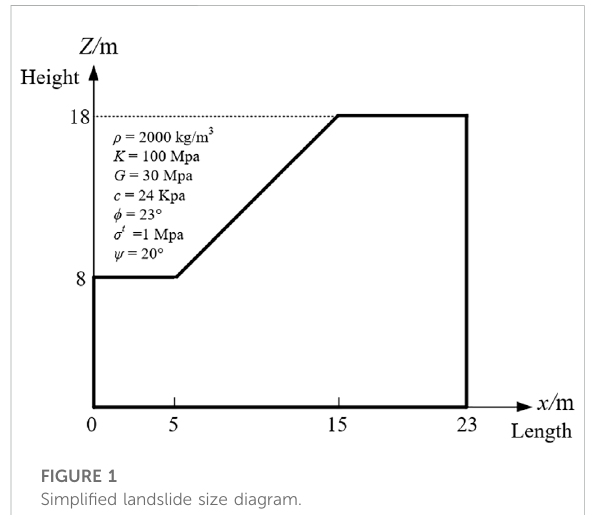
FIGURE 1 Simpli fi ed landslide size